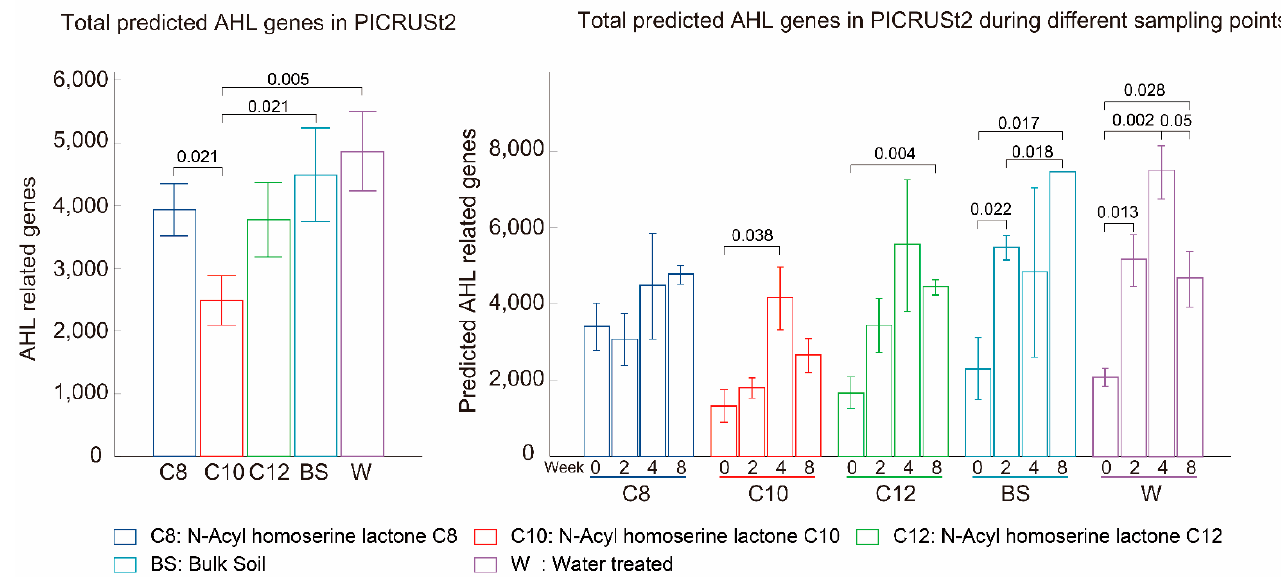
Figure 5. Bar graph showing the amount of quorum sensing related genes on the total ( A ) and different samples across different sampling time points ( B ). The significance values were generated according to one-way ANOVA with Duncan’s multiple range test values ( p < 0.05).